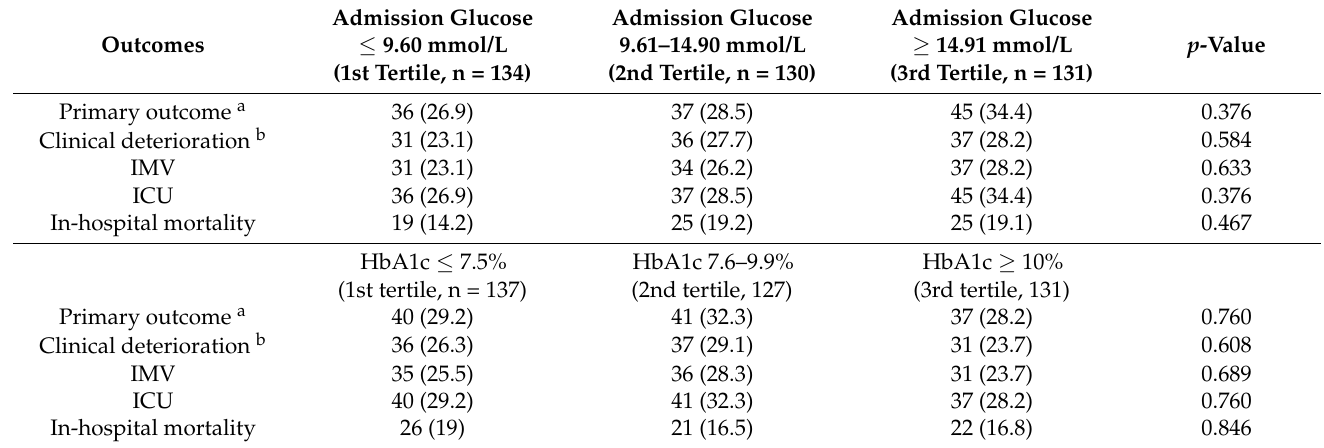
Table 3. The primary and secondary outcomes according to admission glucose and HbA1c